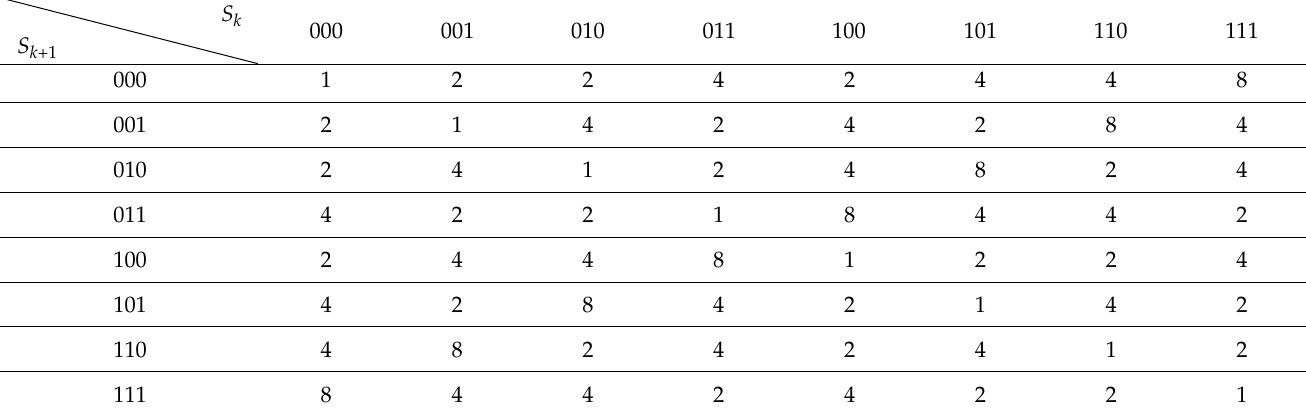
Table 1. The original weight of the switching